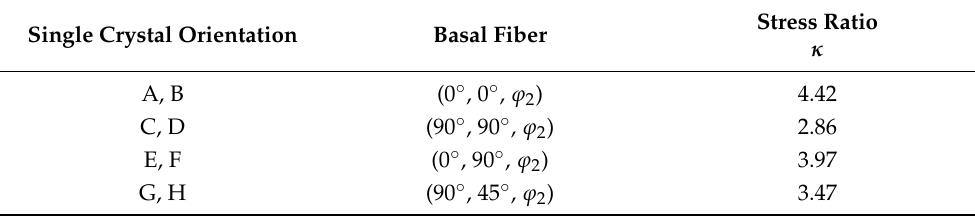
Table A1. Calculated stress ratio κ between the active (in CD) and reaction (in TD) stress components of the biaxial stress state in channel-die compression for various tested single crystal orientations and the Euler angles defining the basal fiber for which the respective κ ratio is